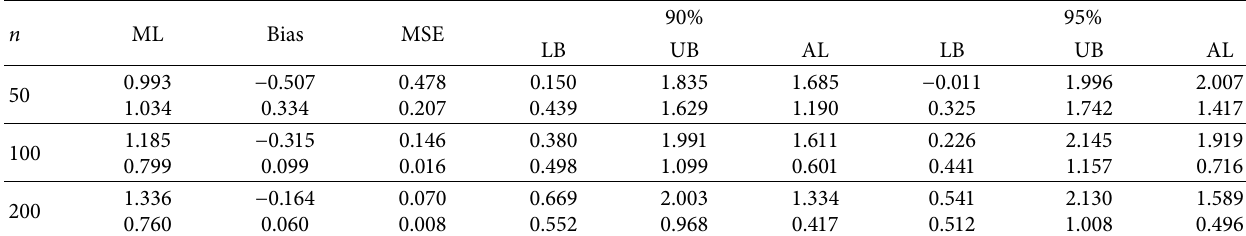
Table 5: ML estimates, biases, MSE, LB, UB, and AL of the TLIL model for α � 1.5, θ �